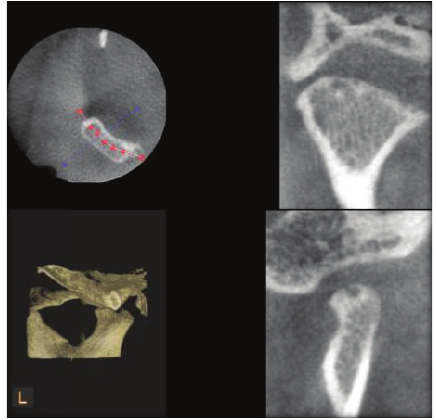
Figure 9: Ely’s cyst of condyle as seen in DVT.